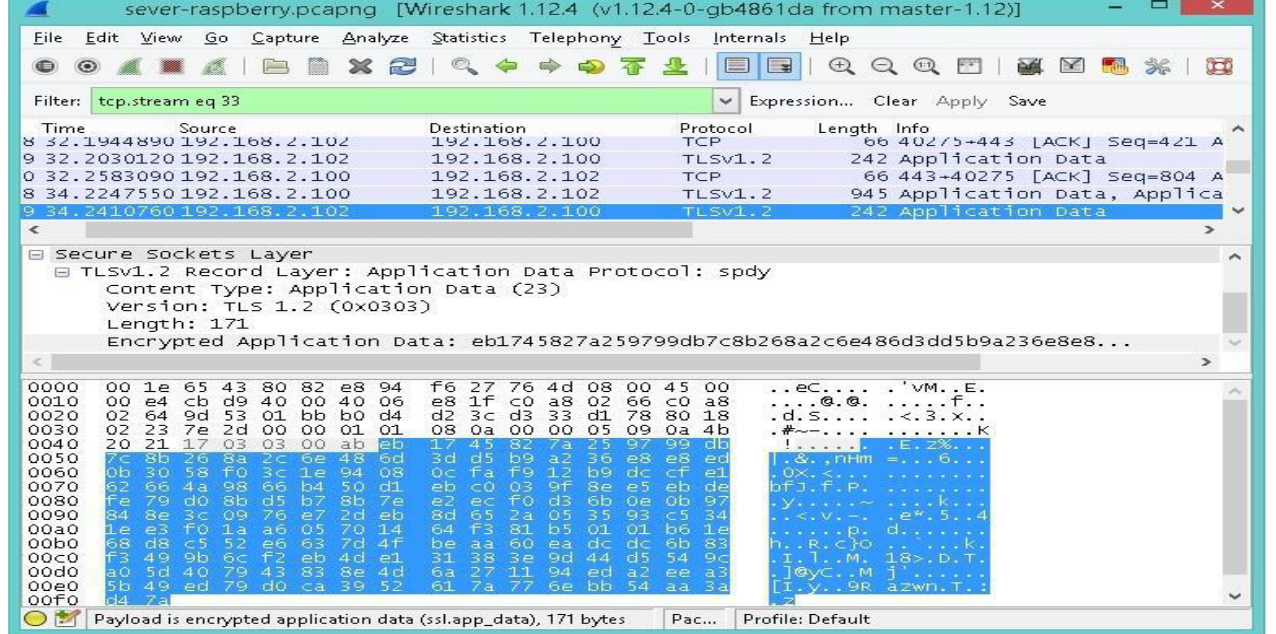
Figure 12. Captured TLS Packet from Web